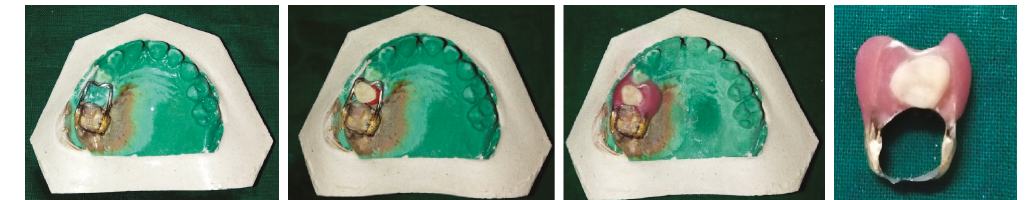
Figure 1: Steps in the construction of a functional band and loop space maintainer.